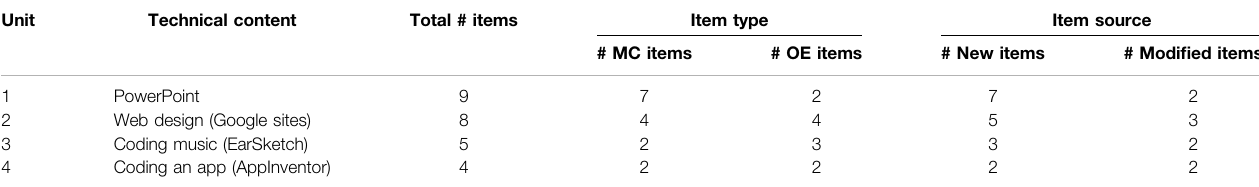
TABLE 2 | Unit assessments with item counts, types and